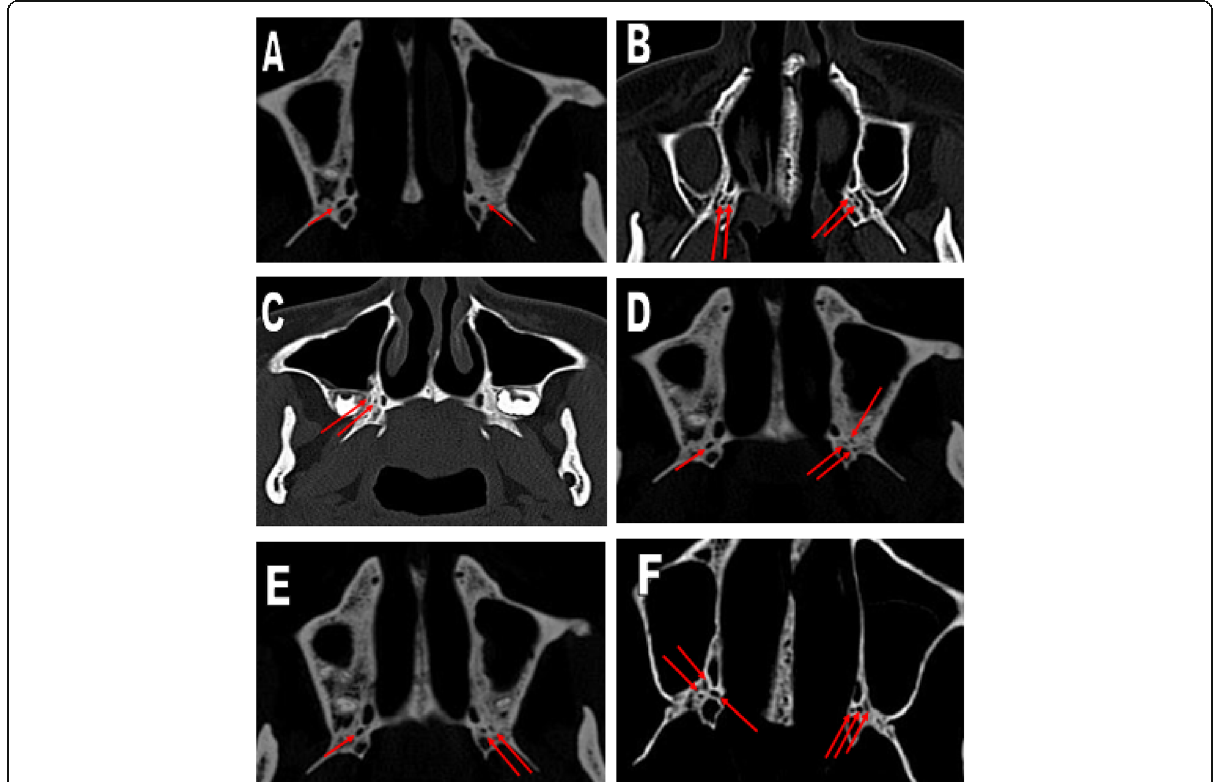
Fig. 5 A CT scan at the region of the hard palate in different patients. a Single LPF on both sides. b Two LPF on both sides. c Two right LPF and absent left. d Single LPF on the right side and 3 LPF on left side. e Single LPF on the right and two LPF on left side. f Three LPF on both sides